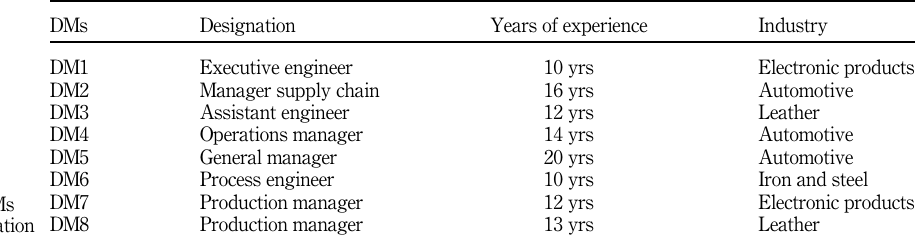
Table 1. Introduction of DMs with their